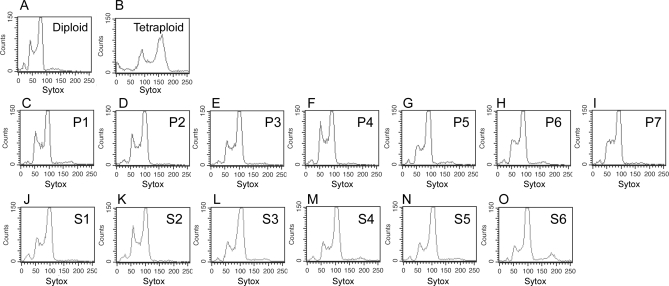
Analysis of Progeny Strains from the Parasexual Mating Cycle by Flow CytometryProgeny strains derived from the tetraploid RBY18 were grown in liquid YPD medium, as described in Materials and Methods. Strains P1 to P7 (C–I) were derived from growth of RBY18 on pre-spo medium, while strains S1 to S6 (J–O) were derived from growth of RBY18 on sorbose medium. In both cases, progeny strains were found to be diploid, or near diploid, by flow cytometric analysis. For comparison, a parental diploid strain (A) and tetraploid strain (B) were also analyzed by flow cytometry. The x-axis of each graph (Sytox) represents a linear scale of nuclear fluorescence, and the y-axis (Counts) represents a linear scale of cell number.